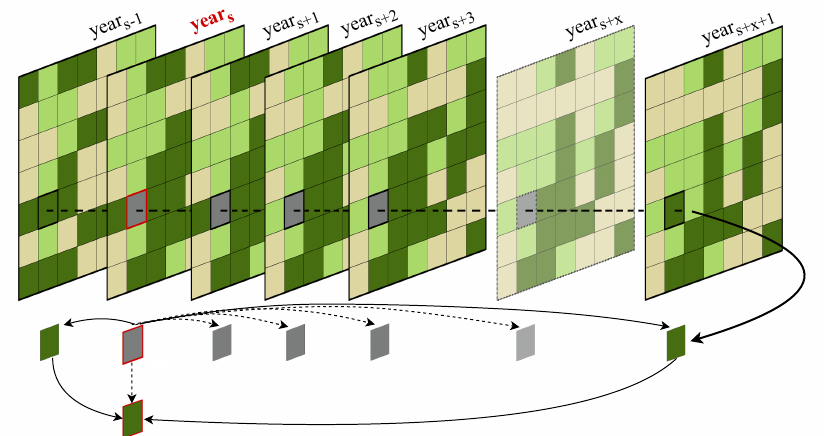
Figure 6. Schematic illustration of the cloud filter after the classification: Each pixel, classified as Cloud in Year s is compared with the same pixel of Year s − 1 and the following years (Year s + x ). Cloud pixels of Year s are replaced by the class which is classified both in the year before the first cloud pixel (Year s − 1 ) and the year after the last successive cloud pixel (Year s + x + 1 ). In this example, the cloud pixel of Year s is replaced by a forest